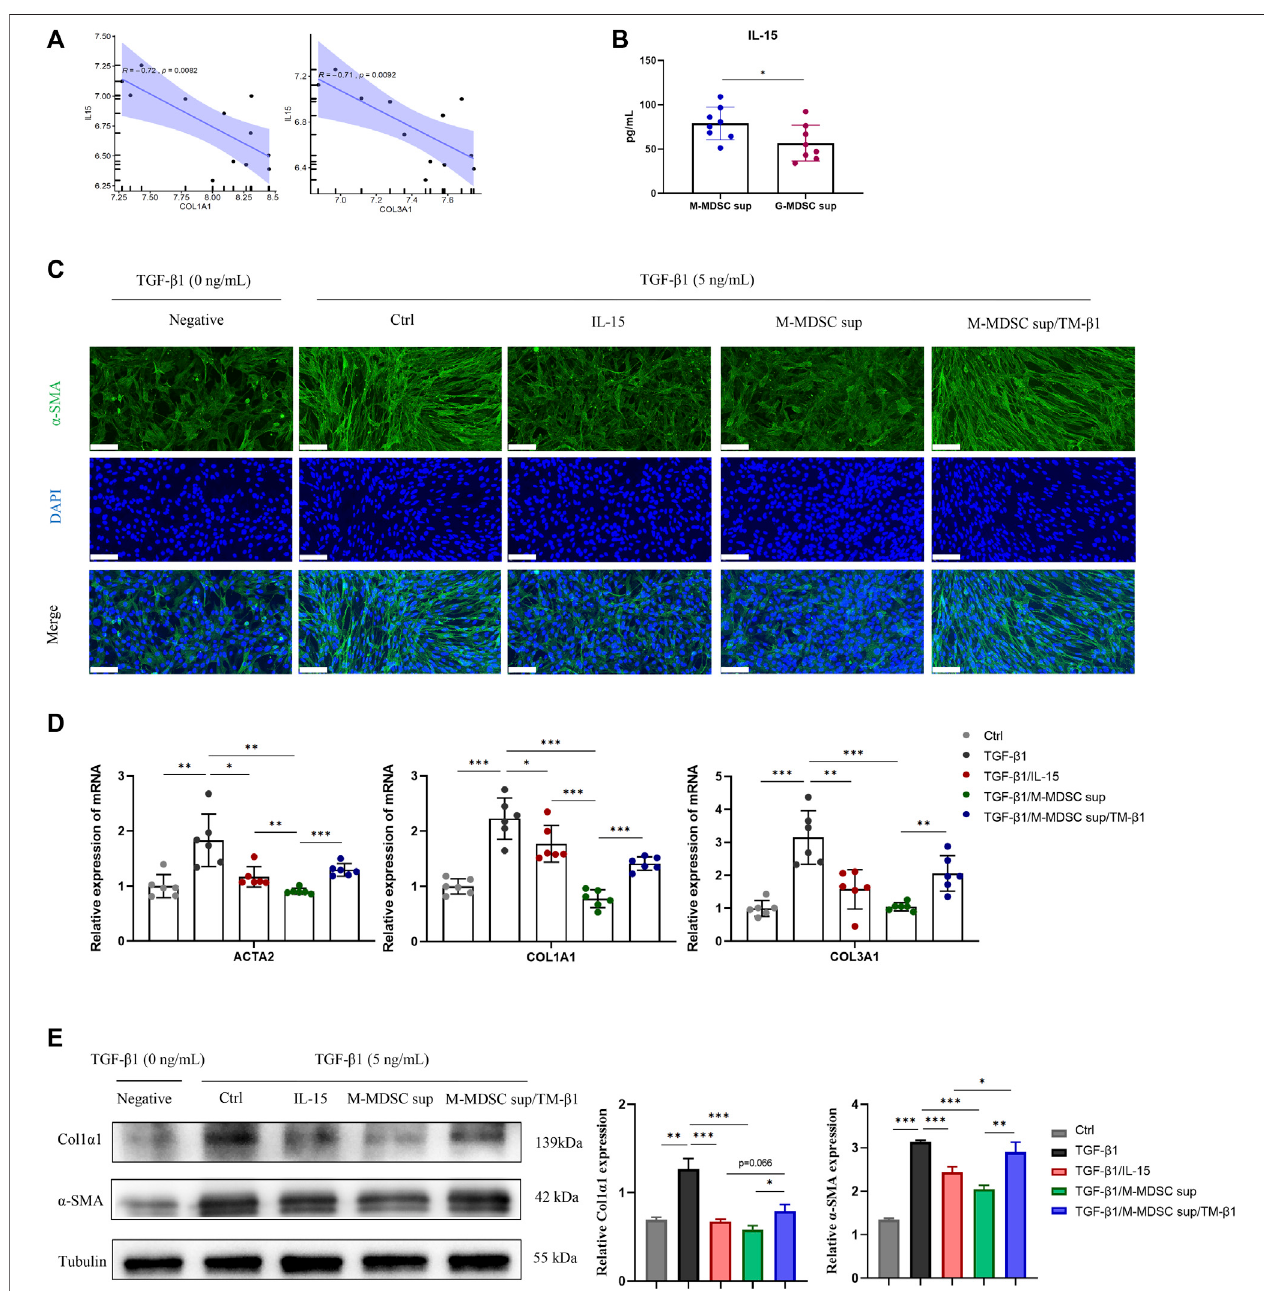
FIGURE 3 | M-MDSC-derived IL-15 plays a critical role in the suppression of myo fi broblastic differentiation. (A) The expression of COL1A1 and COL3A1 was inversely related to IL-15 expression in the published GSE83610 dataset. (B) The level of IL-15 in M-MDSC and G-MDSC supernatants was measured by ELISA. (C) MSCs were cultured with TGF- β 1 (5 ng/mL) for 24 h with or without IL-15 (1 ng/mL), M-MDSC supernatant and TM- β 1 (10 ng/mL). α -SMA in MSCs was measured by immuno fl uorescencestaining.Scalebar:100 μ m. (D) mRNAexpressionofACTA2,COL1A1andCOL3A1inMSCswasnormalizedtoGAPDHexpression.Values wereexpressed asmean ± standarddeviation(mean ± SD). (E) Representativewesternblotandaveragedatafor α -SMAandcol1 α 1inmesenchymalstemcellsofeach experimental group, normalized to expression of tubulin. Values were expressed as mean ± standard deviation (mean ± SD). * p < 0.05; ** p < 0.01; *** p < 0.001.